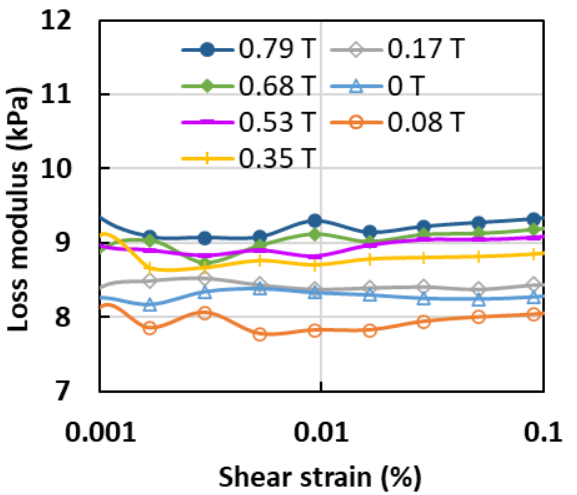
Figure 5. Loss modulus versus shear strain at different magnetic field strengths and constant frequency of 1 Hz.